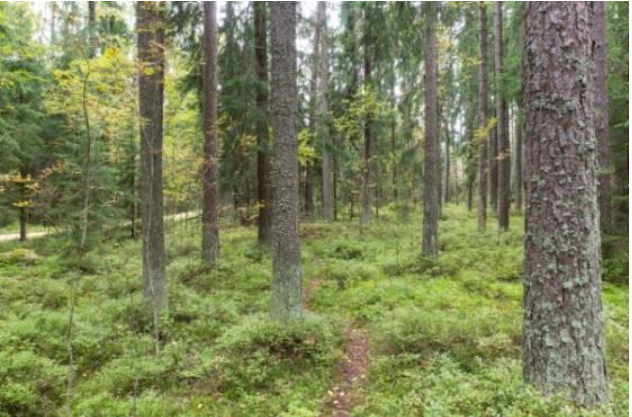
Figure 1. The urban recreation forest (Urban). This picture was published in Reference [66].